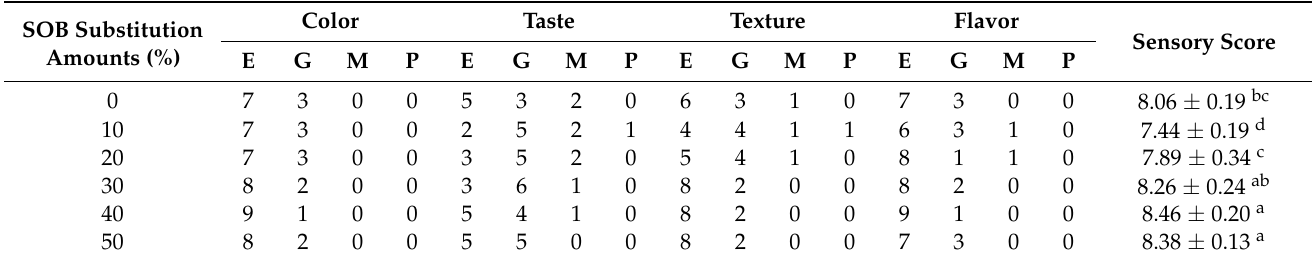
Table 4. Effects of different SOB substitution amounts on the sensory score of ice